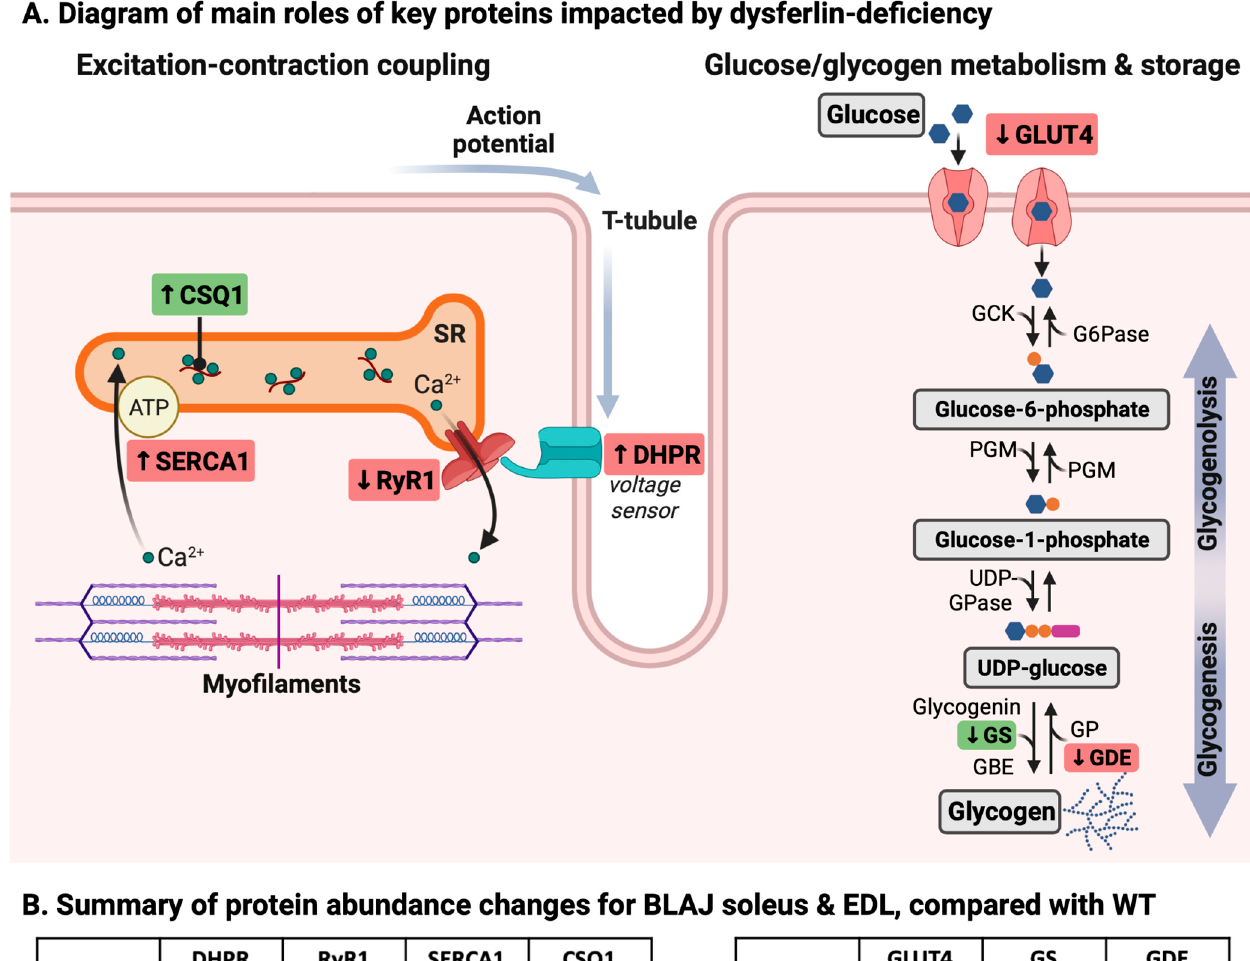
Figure 5. These protein level changes likely relate to published observations of dysf − / − my ‐ ofiber ‐ type specific differences reported for function and metabolism, as discussed below.